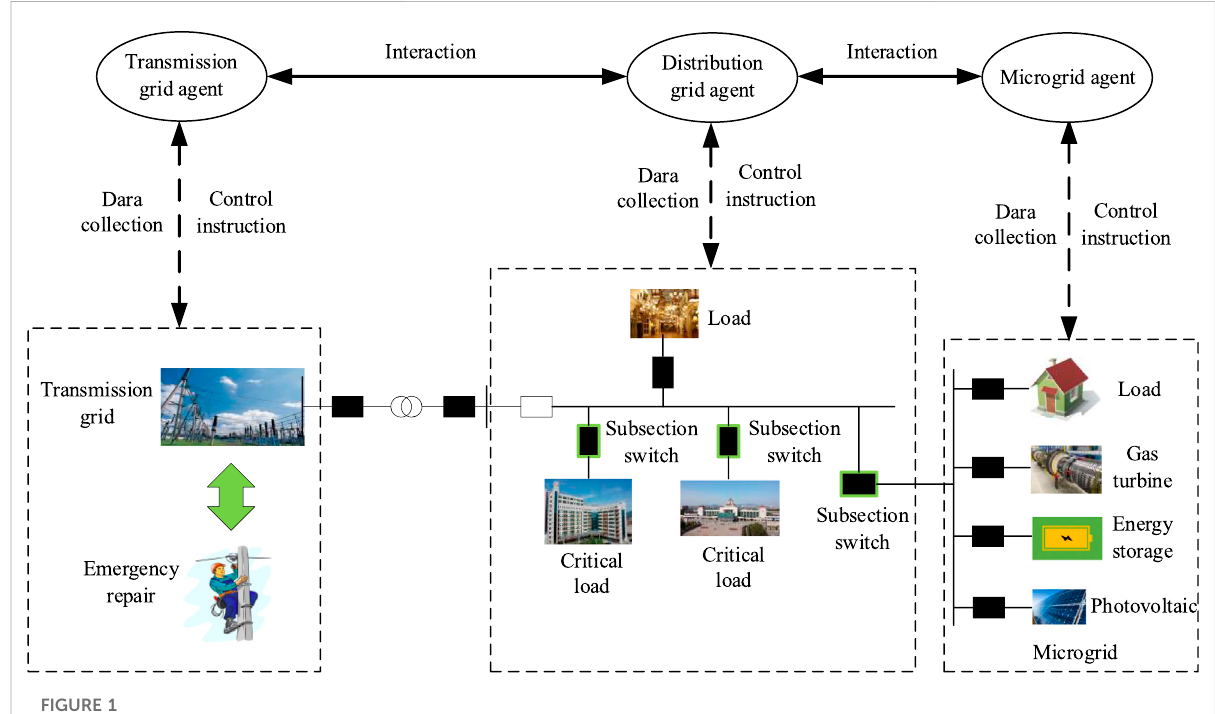
FIGURE 1 Framework of multi-agent system-based substation load restoration